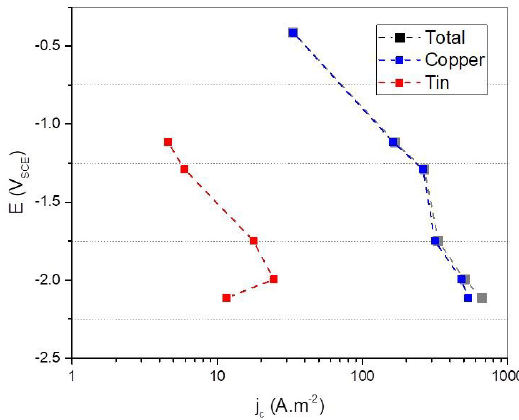
Figure 2. Partial polarization curves for copper and tin deposition during the SPC process. The total polarization curve is also presented for